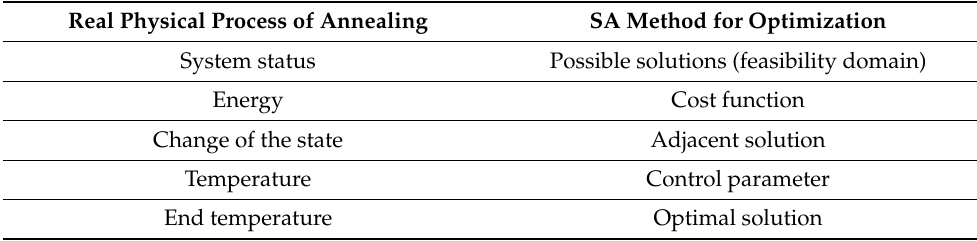
Table 5. Analogy between real physics annealing and SA method for